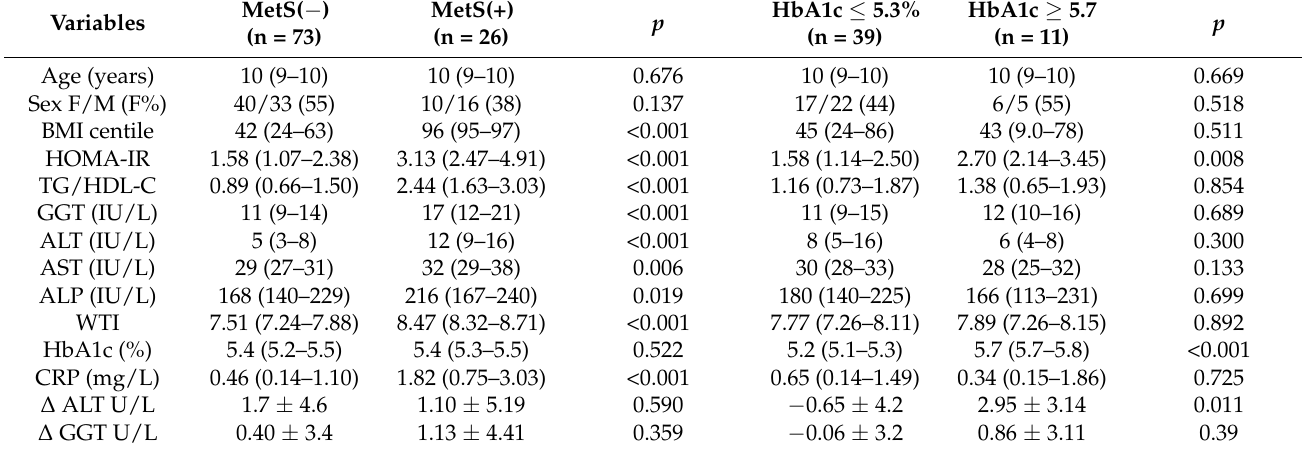
Table 1. Basal characteristics of study